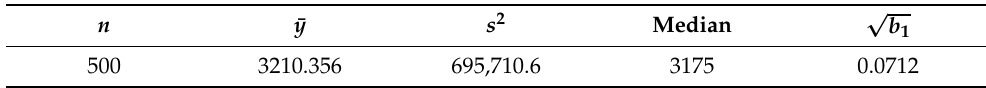
Table 2. Descriptive summaries for b.weight